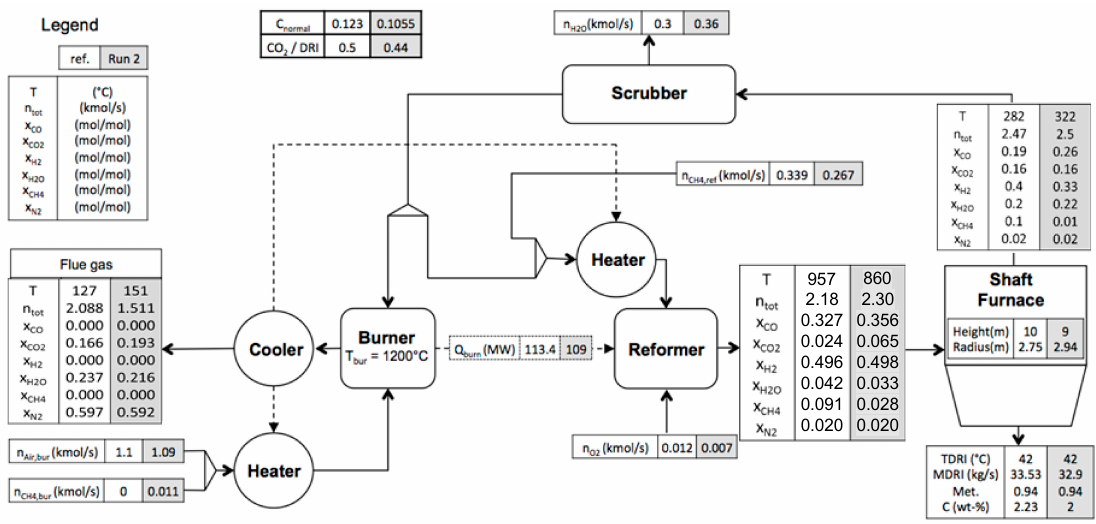
Figure 4. Visual representation of the main results for reference case and run 2.